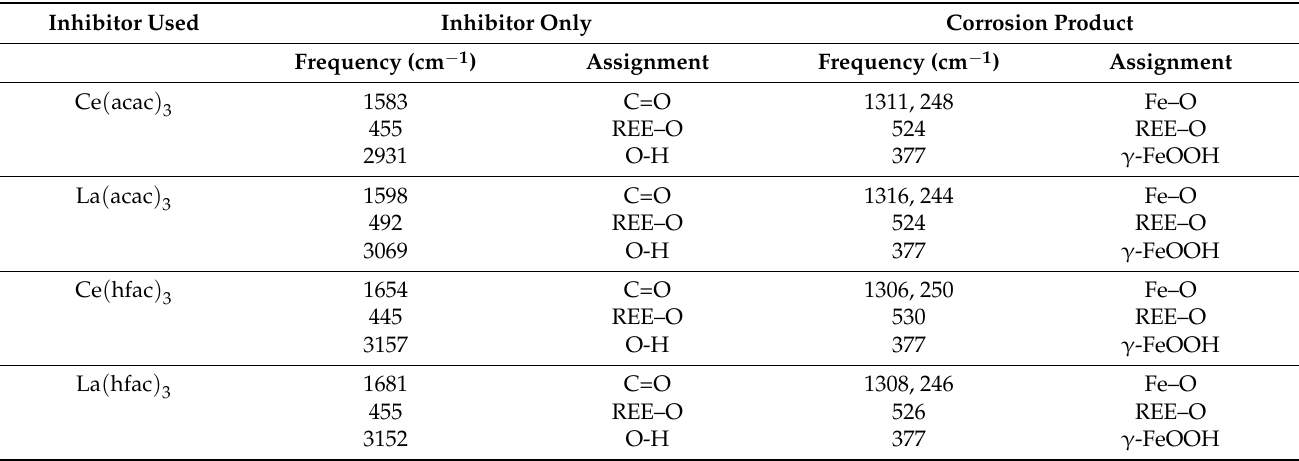
Table 6. Raman frequency band of Ce ( acac ) 304 stainless